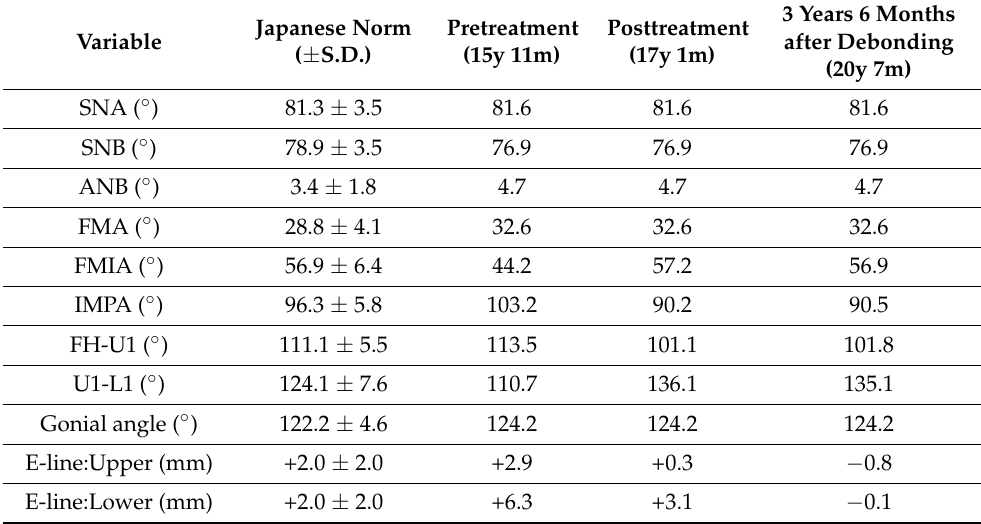
Table 1. Cephalometric measurement at pretreatment and